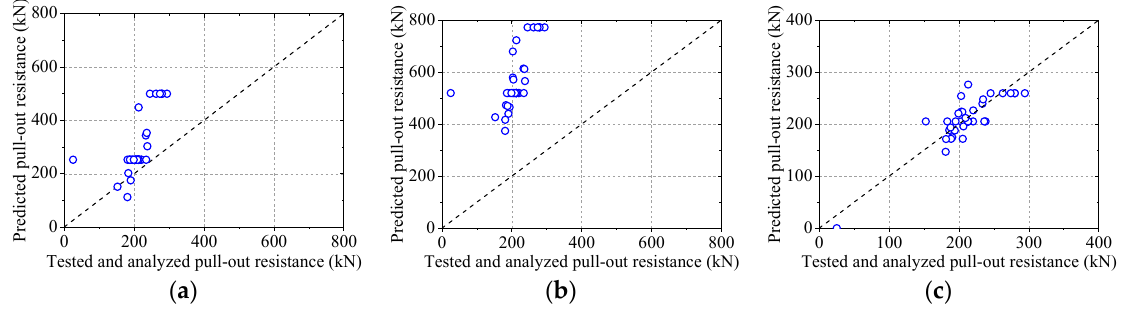
Figure 21. Evaluation of pull-out resistance equations. ( a ) Leonhardt et al.; ( b ) Hosaka et al.; ( c ) proposal.